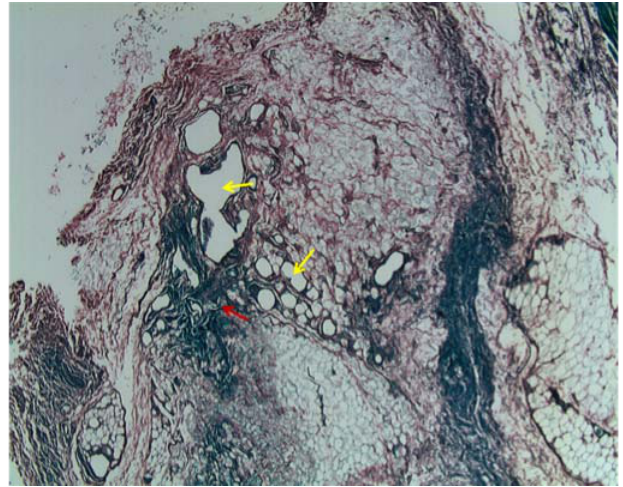
FIGURE 7 – Photomicograph of rabbit 5. Greater presence of fibroses, inflammatory tissue and macrophage infiltration in the animal with the lower weight (Chi-square test, p<0.05). Fibrosis (red arrow), microcysts (yellow arrow) Picrosirius red